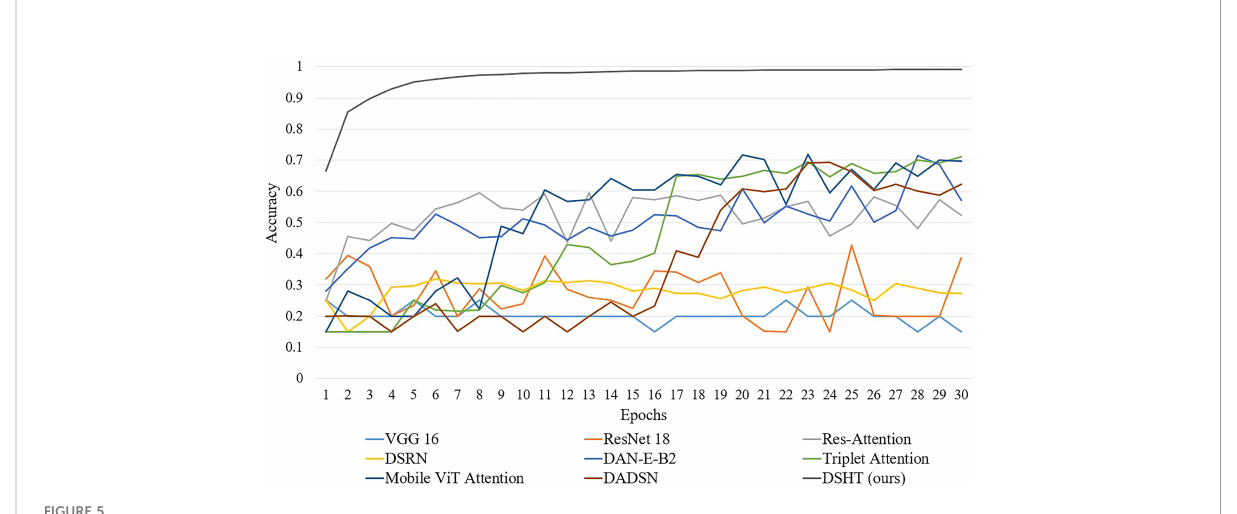
FIGURE 5 Validation Accuracy Curves of Comparison Models.